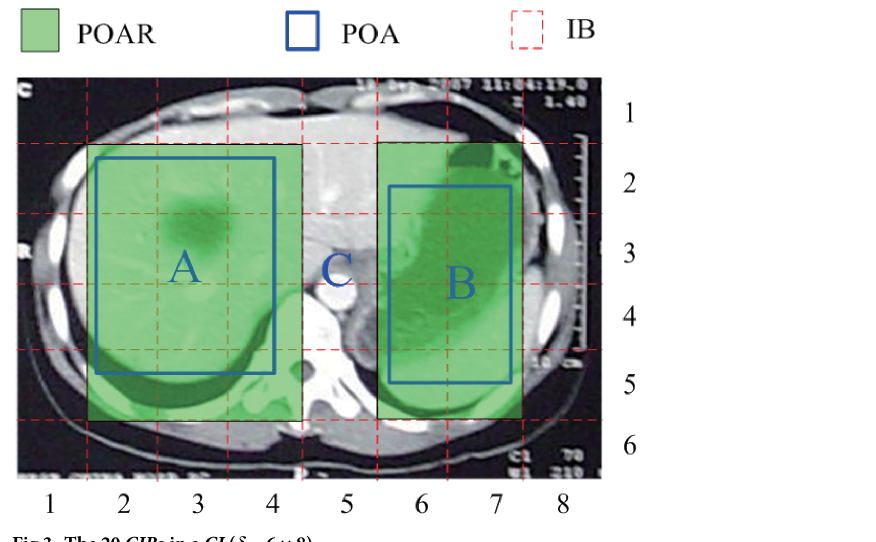
Fig 3. The 20 CIB s in a CI ( δ = 6 ×